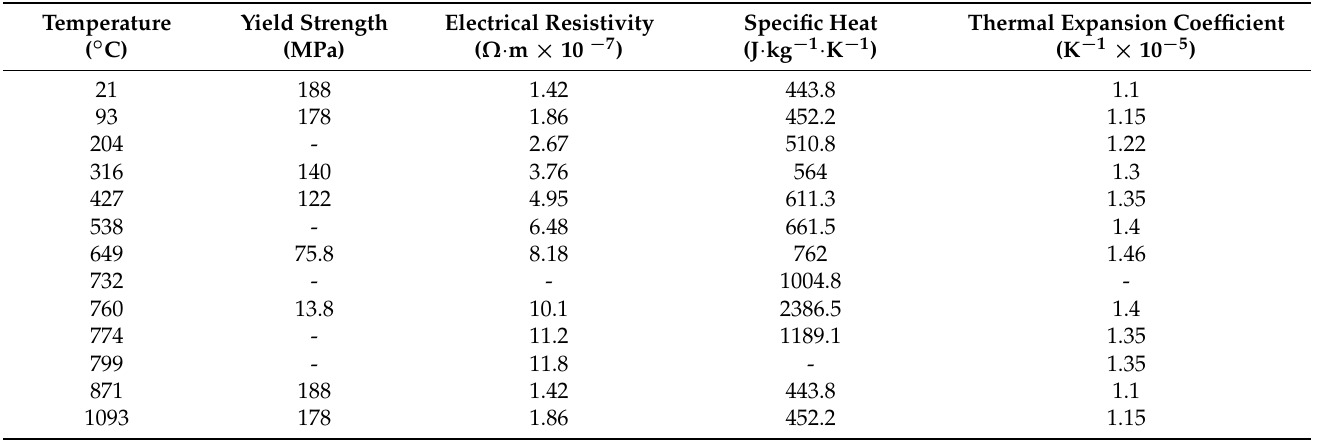
Table A2. Thermo-physical properties parameters of